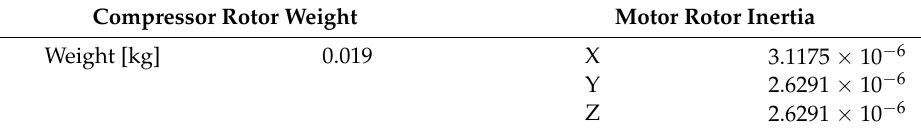
Table 4. Compressor data.